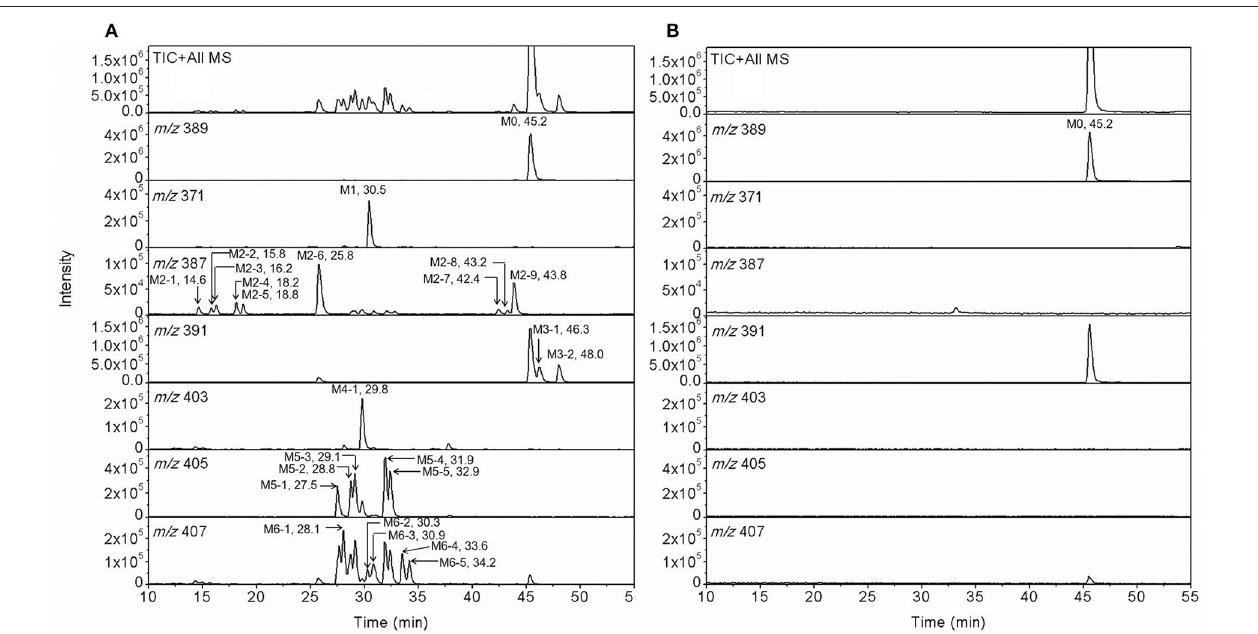
FIGURE 2 | Representative extracting ion [M + H] + chromatograms of F18 and its metabolites in HLM incubation with (A) and without NADPH-regenerating system (B) . The 23 detected metabolites are labeled M1 ( m/z 371), M2 ( m/z 387), M3 ( m/z 391), M4 ( m/z 403), M5 ( m/z 405), and M6 ( m/z 407), and the parent compound is labeled M0 ( m/z 389). The metabolites were numbered according to their chromatographic retention times.